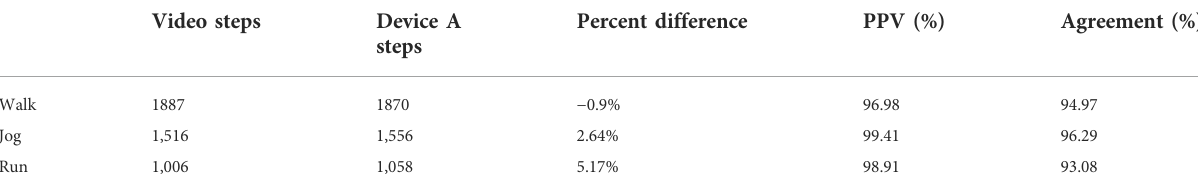
TABLE 3 The validity of Bioharness